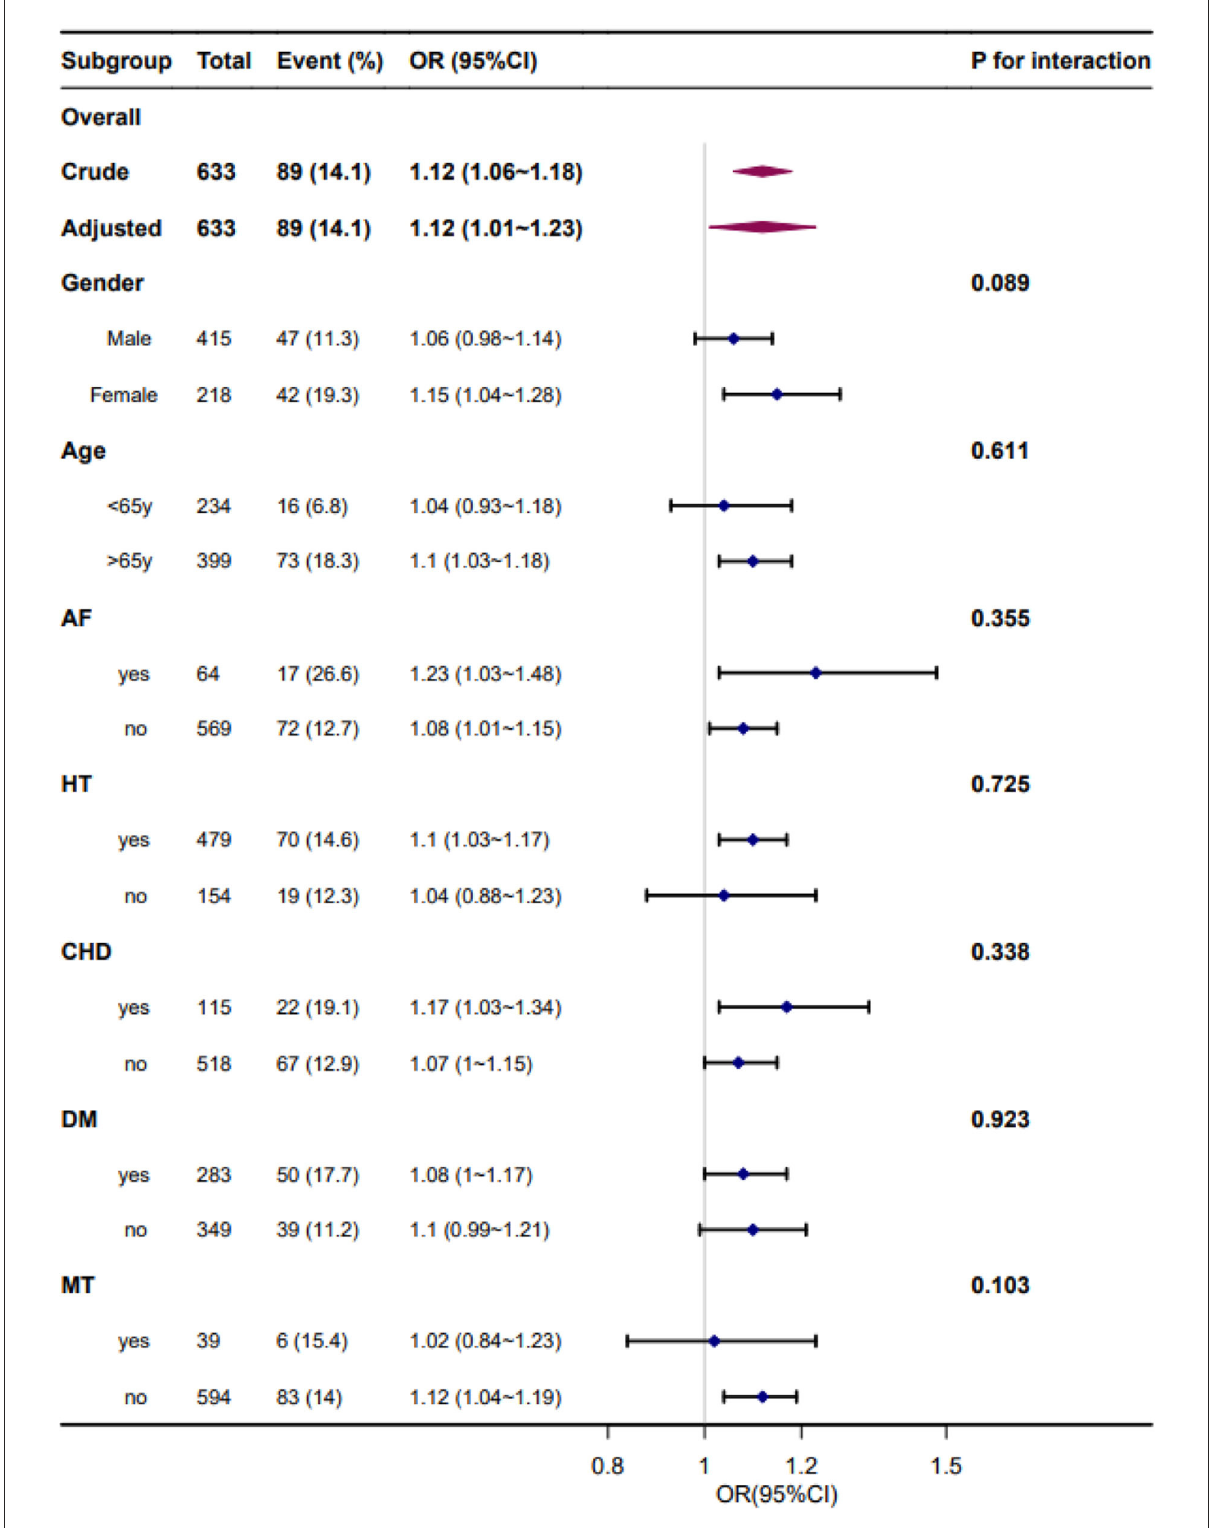
FIGURE4 Forest plot of the standard deviation of systolic blood pressure and adverse outcomes by subgroup and interactions. Adjusted for age, sex, smoking, alcohol consumption, hypertension, fasting plasma glucose at enrollment, low-density lipoprotein, neutrophils, TOAST classification, NIHSS score at enrollment, early neurological deterioration, and mean blood pressure. AF, atrial fibrillation; HT, hypertension; CHD, coronary heart disease; DM, diabetes mellitus; MT, mechanical